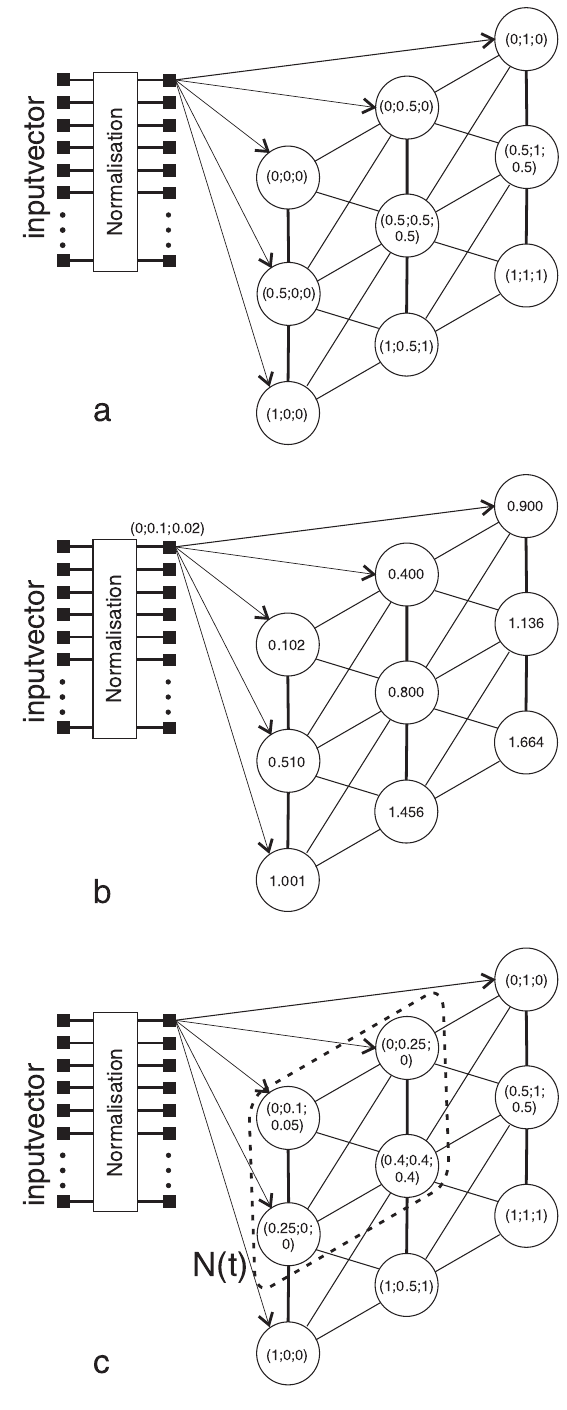
Fig. 1. SOM-algorithm (a) Initialization reference vectors of the units (b) Calculation of Euclidean distance between input vector and ref- erence vectors of the units (c) Assignment of input vector to its BMU and update of reference vectors of the units within neighborhood